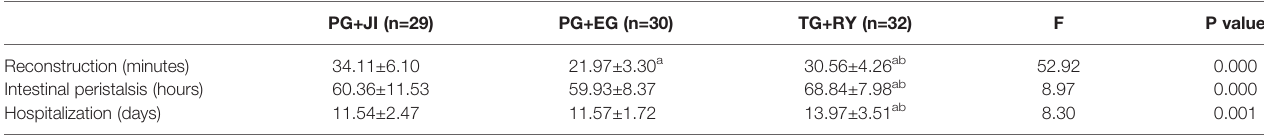
TABLE 2 | Clinical outcomes.